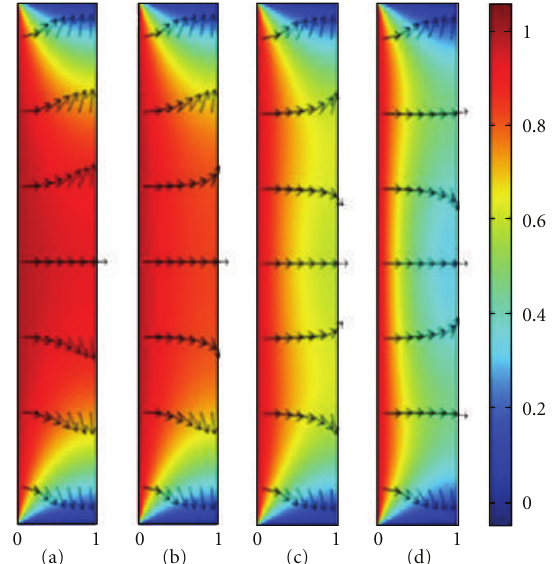
Figure 6: Distribution of dimensionless methanol concentration at l = 25 μ m, a = 1 . 0 × 10 5 m − 1 , E 0 = 0 . 5V, κ e = 3 . 4 Ω − 1 m − 1 , D e = = 1 . 0 M; (b) T = 333 K, 3 . 04 × 10 − 10 m 2 s − 1 ; (a) T = 303 K, c 0 M c 0 M = 1 . 0 M; (c) T = 363K, c 0 M = 1 . 0M; (d) T = 363 K, c 0 M = 0 . 5 M; arrow: the gradient of dimensionless methanol